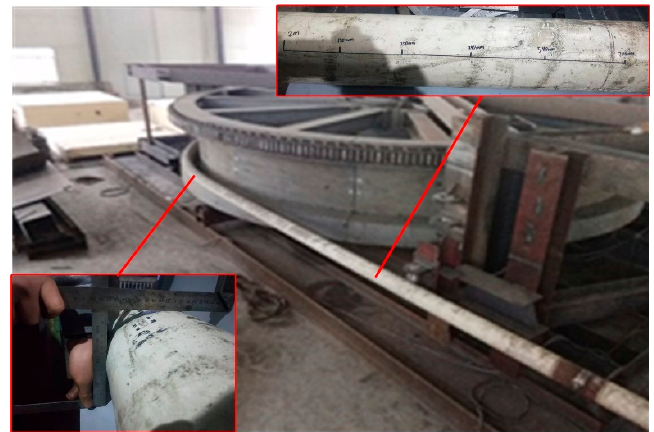
Figure 4. Relation between stress and strain of the material.